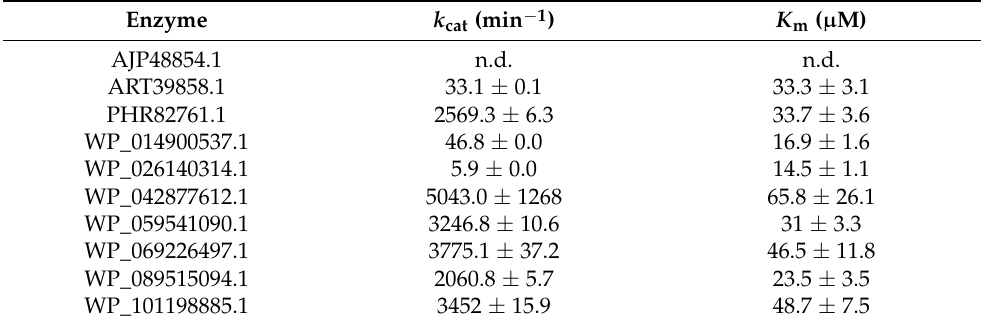
Table 2. Kinetic parameters of selected hydrolases for p -NP propionate. The results are the mean ± SD of triplicates. Note: Kinetic parameters could not be determined (n.d.) because no reliable K m could be determined (low affinity for the substrate under our experimental